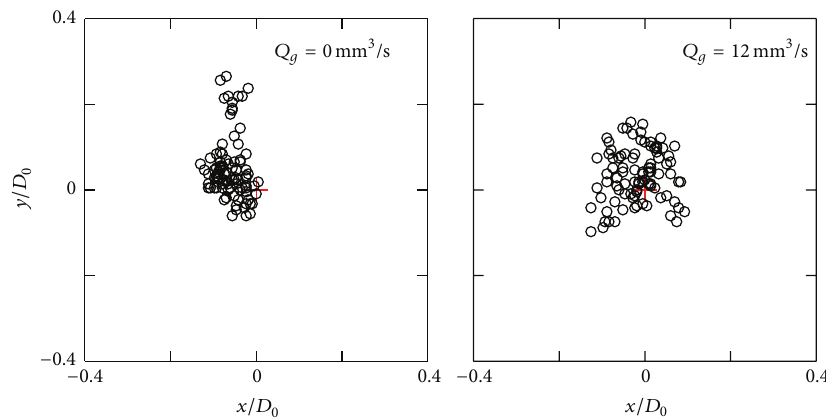
Figure 17: Locus for the upper end of vortex core when Ω = 11.7 × 10 4 .